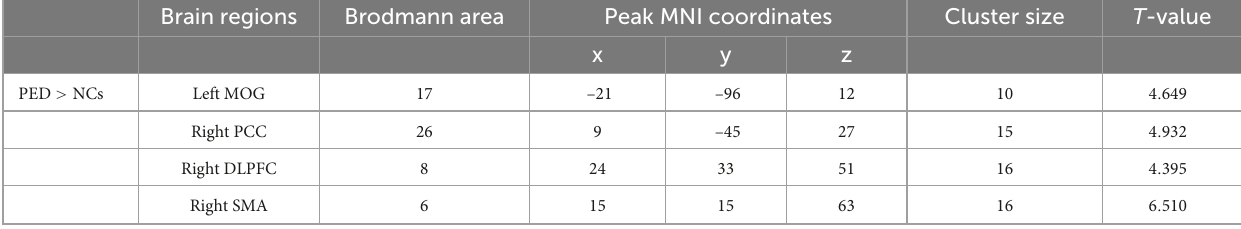
TABLE 3 Brain regions with different fALFF values between PED patients and NCs.